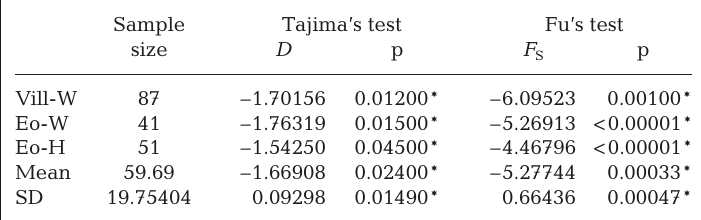
Table 4. Neutrality statistics for Ruditapes decussatus from Ría de Villavi- ciosa (Vill) and Ría del Eo estuaries in Asturias, northern Spain, using the mtCOI gene (503 bp). W: wild, H: hatchery. *Significant at p <